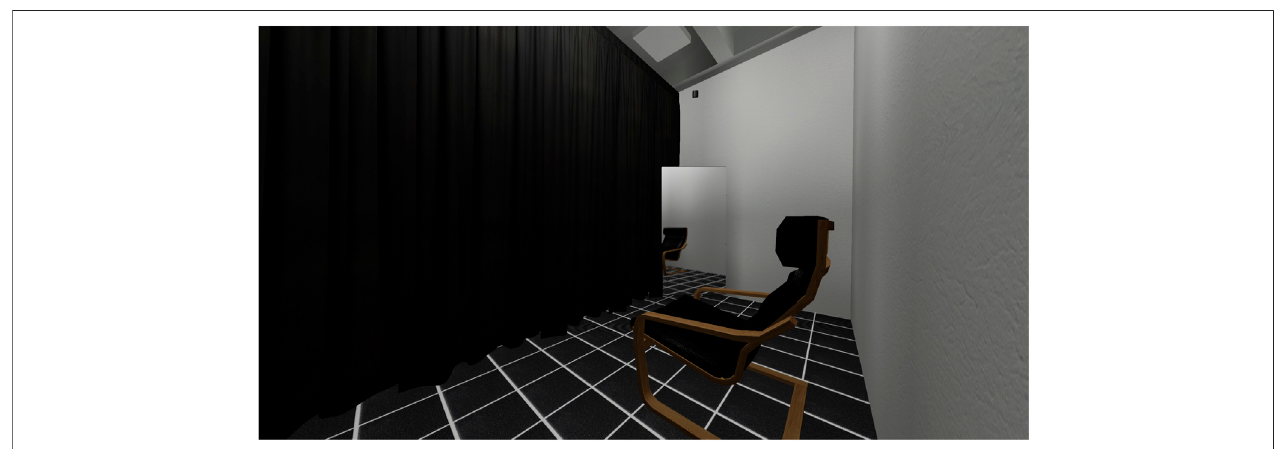
FIGURE 2 | Picture of the virtual environment: It was taken from a third person view.